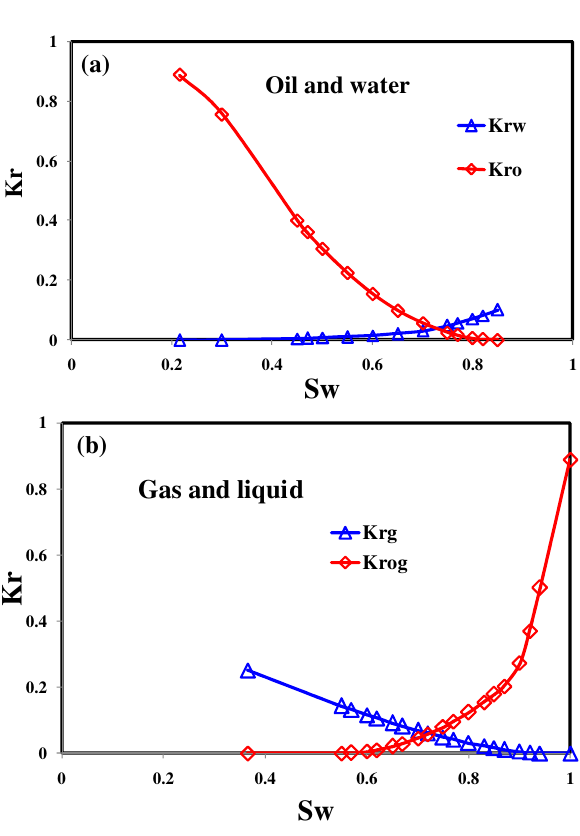
Fig. 2 The relative permeability adopted in the numerical